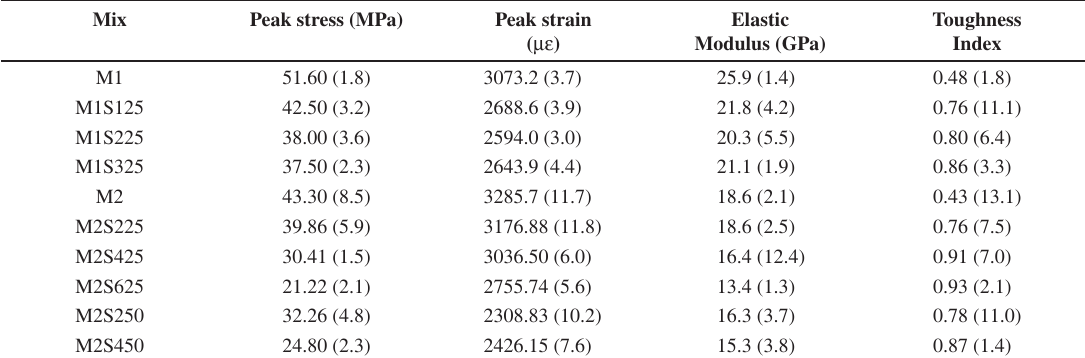
Table 3. Peak stress and strain, elastic modulus and toughness of the studied composites.